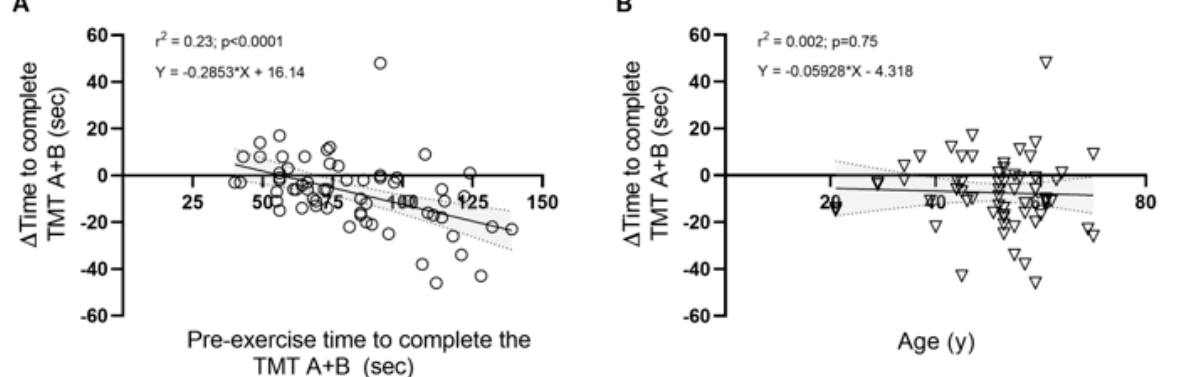
Figure 1. Participants completed the Trail Making Test A + B faster after an acute prolonged exercise session (n = 62; 21–70 years of age). Data analyzed via paired sample t -test. Table 2. Effect sizes for comparisons of time to complete cognitive task (pre vs. post-exercise).